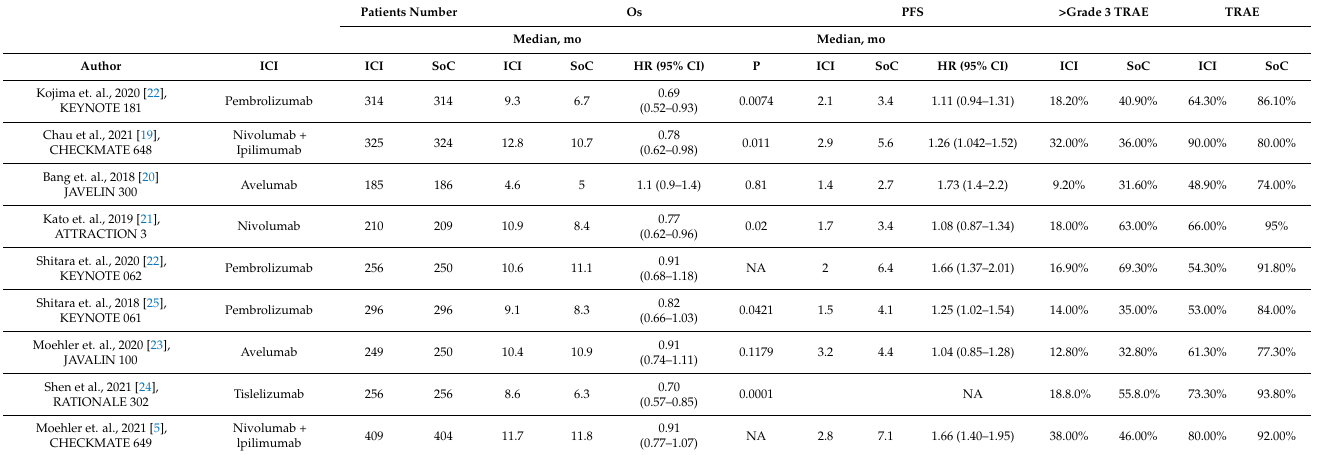
Table 2. Included studies in the subgroup immunotherapy vs.